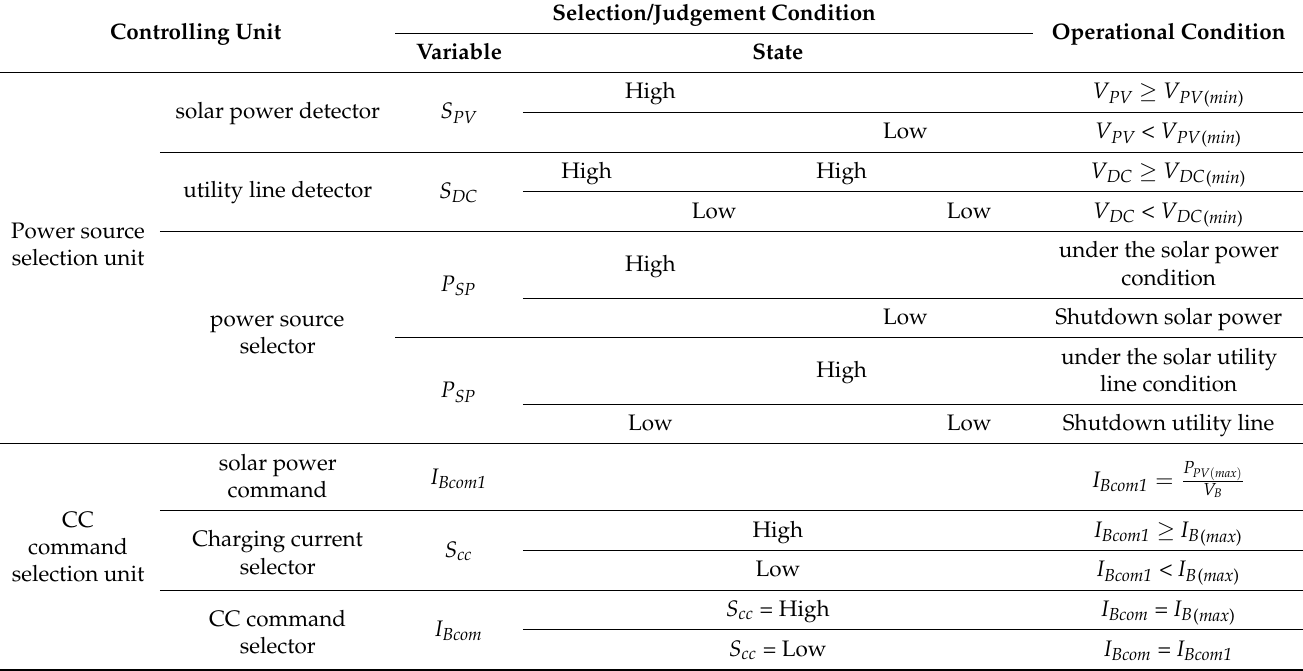
Table 3. Operational condition of the proposed hybrid converter for the controller